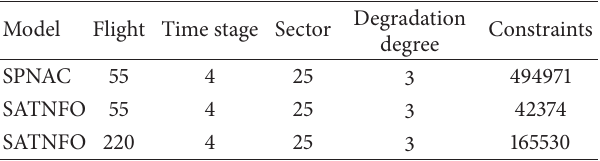
Table 3: Numbers of constraints of SATNFO model and SPNAC